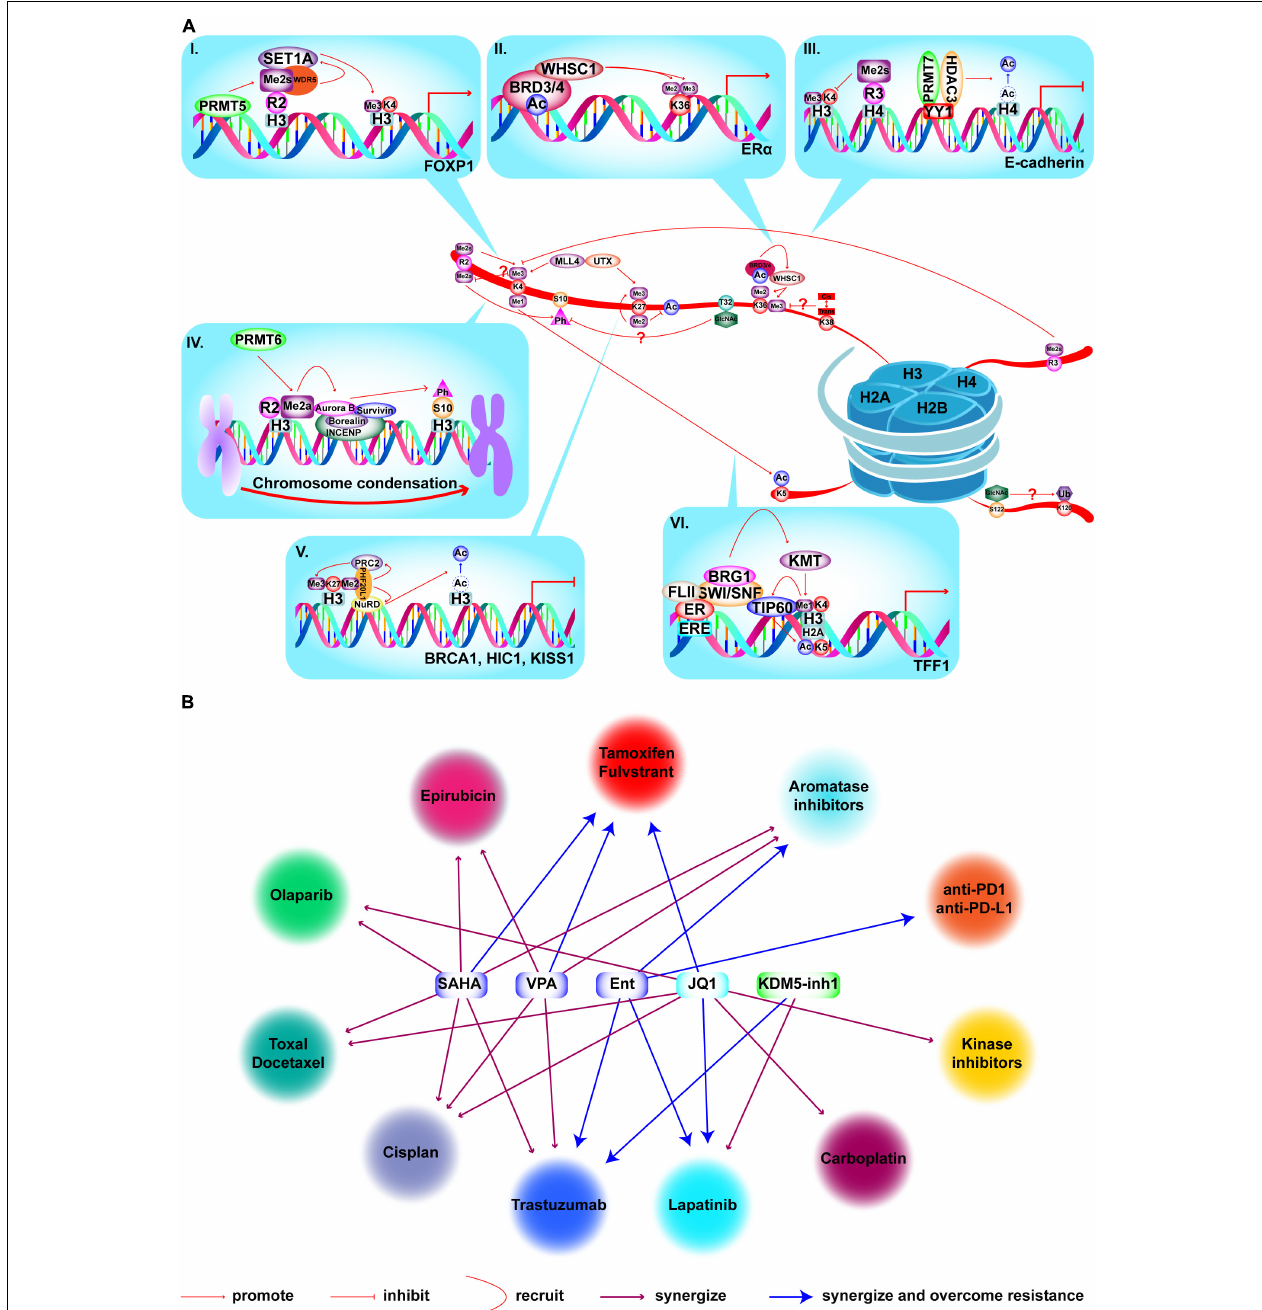
FIGURE 7 | Crosstalk among HMs and combined treatments with epi-drugs in BC. (A) Crosstalk among HMs and mechanisms in BC. (I) PRMT5 is recruited to FOXP1 promoter to catalyze H3R2me2s which is recognized by WDR5. WDR5 further recruits SET1 to catalyze H3K4me3 to activate transcription which results in enhanced BC stem cell function. (II) WHSC1 is recruited to ER α promoter by BRD3/4 and catalyze H3K36me2/3 to promote transcription and tamoxifen resistance. (III) PRMT7 and HDAC3 are recruited by YY1 to E-cadherin promoter and catalyze H4R3me2s and deacetylation of H4. Elevated H4R3me2s antagonizes H3K4me3 deposition and HDAC3-mediated deacetylation to inactivate E-cadherin transcription and lead to BC metastasis and EMT. (IV) PRMT6 catalyzes H3R2me2a to recruit the chromosomal passenger complex that includes Aurora B, Borealin, INCENP, and Survivn to catalyze H3S10p to promote chromosome condensation. (V) PHF20L1 promotes BC tumorigenesis by coordinating corepressor complex complex. PHF20L1 recognizes H3K27me2 to recruit PRC2 and NuRD complex which catalyze H3K27me3 and deacetylation of H3K27 to inactivate tumor suppressors transcription, such as HIC1 , KISS1 , and BRCA1 . (VI) After E2 stimulation and MLL1 recruitment, MLL1 catalyzes H3K4me1 and facilitates the recruitment of TIP60 which catalyzes H2AK5ac to promote transcription of ER α target genes. Crosstalk which is marked by “?”, has not been studied for its role in BC. (B) Existing epi-drugs that either synergize or overcome resistance to other anti-cancer drugs in treatment of